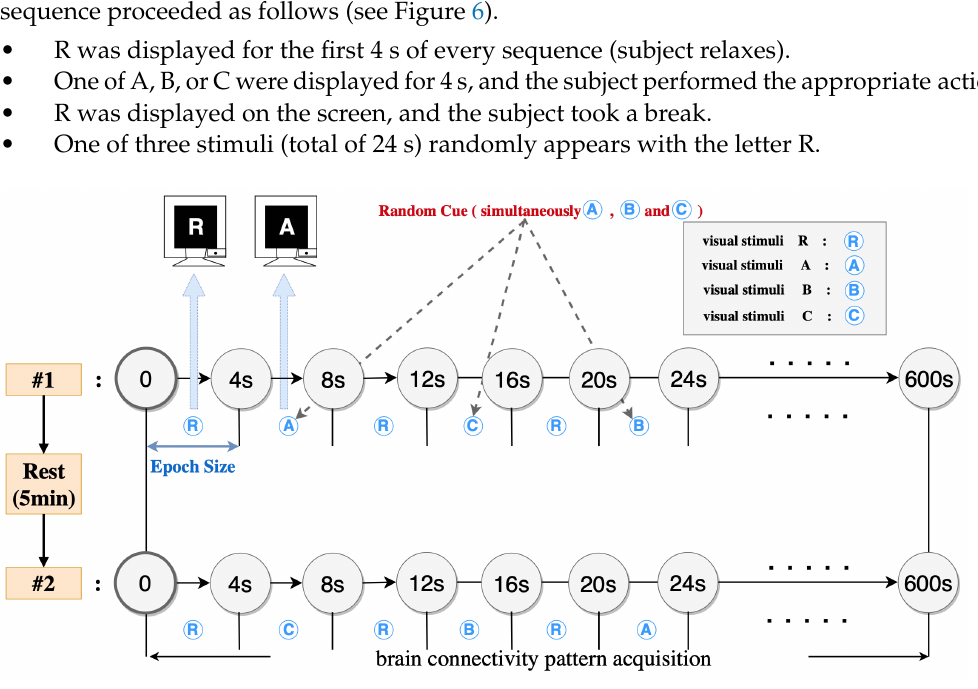
Figure 6. Proposed experimental